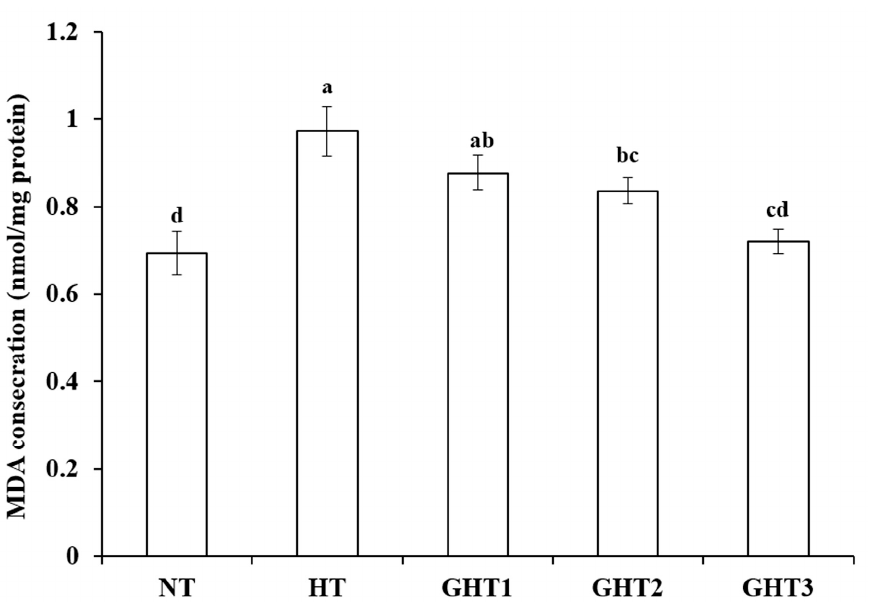
Figure 2. Effect of Gln on MDA level on the livers of broilers exposed to high temperature conditions. Different lowercase letters above each column indicate significant ( p < 0.05) differences among the groups. NT group: Broilers were kept in a normal temperature environment and fed a basal diet. HT, GHT1, GHT2, and GHT3 groups: Broilers in these groups were kept in high temperature conditions and fed a basal diet supplemented with 0%, 0.5%, 1.0%, and 1.5% Gln.